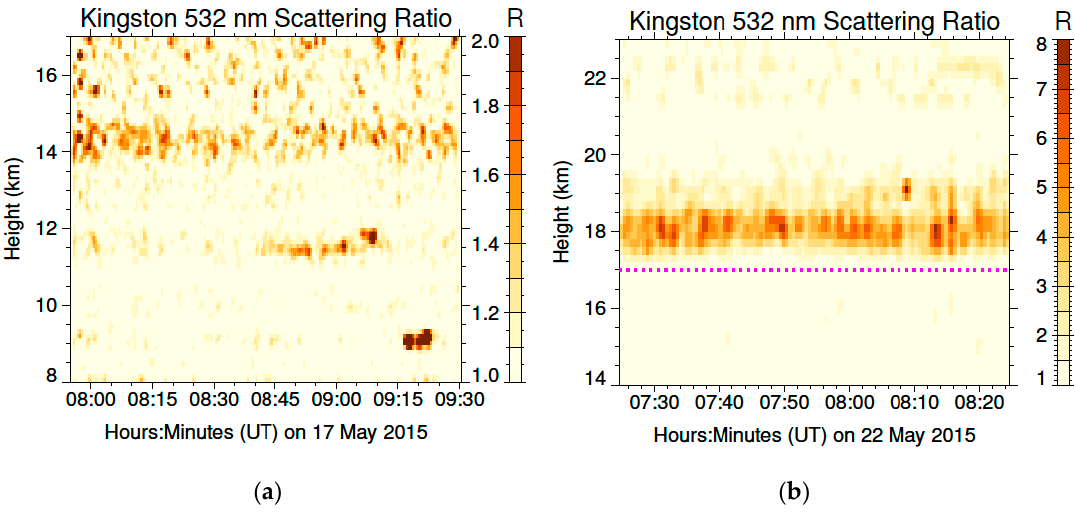
Figure 6 . Height-time display of 532 nm scattering ratio for Kingston lidar measurements on ( a ) 17 May and ( b ) 22 May 2015. The scattering ratio was retrieved in bins of 100 m × 30 s for ( a ) and 100 m × 30 s for ( b ) and has been smoothed by a Gaussian kernel with a full-width at half-maximum of 2 × 2 bins. In ( b ), the magenta dashed horizontal line is placed at a height of 17 km to aid in examining the vertical variation in the height of the main aerosol layer (centered at 18 km) over time. Note that the vertical and horizontal scales are different between ( a ) and ( b ).